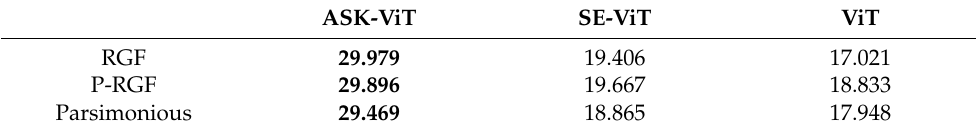
Table 4. Performance of ASK-RVT with SE-ViT and ViT in defending against black box